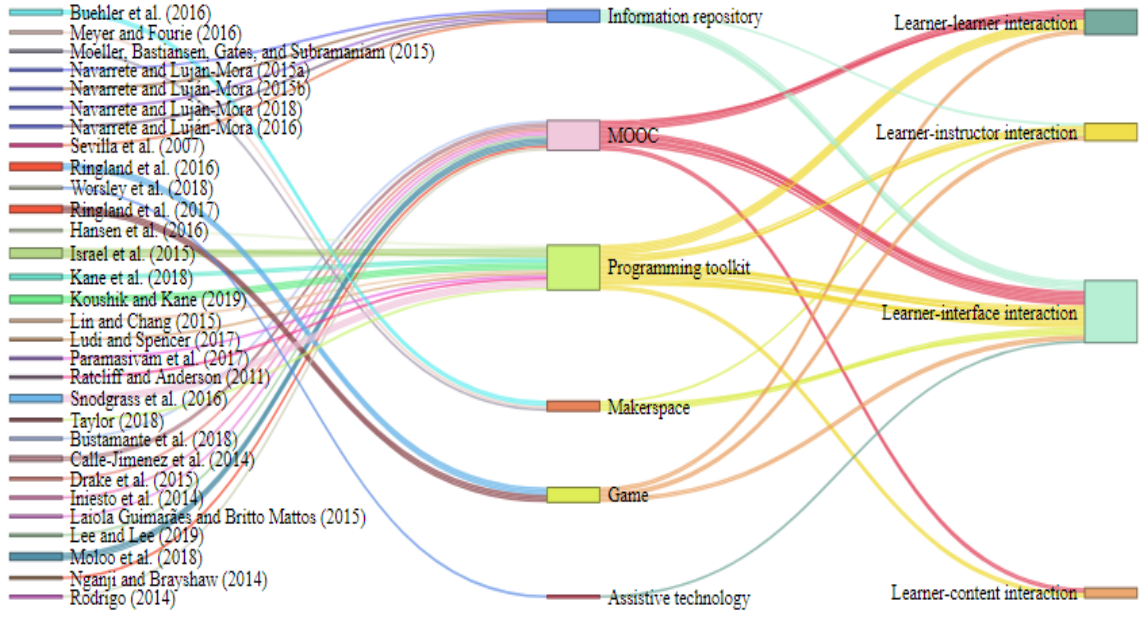
Figure 3 Types of Learner Interactions and OER Platforms in the Selected